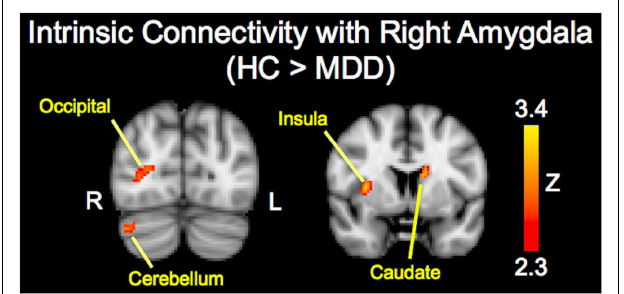
FIGURE 2 | Brain regions showing reduced resting-state functional connectivity with the right amygdala in depressed patients compared with healthy controls . Colored areas indicate significant Z -scores as determined by fMRI. Statistical threshold of Z = 2.3 ( p =